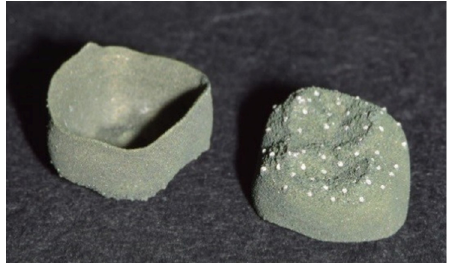
Figure 6. SLM frameworks after relief firing.